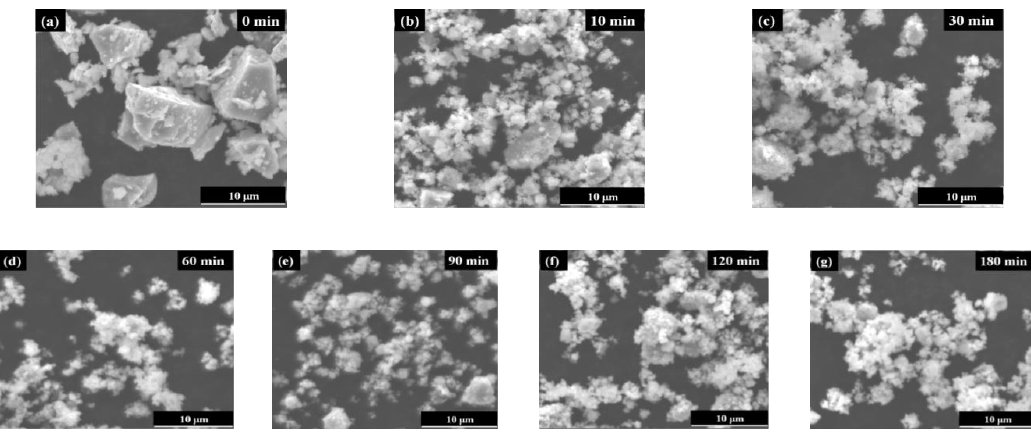
Figure 3. SEM micrographs of chalcopyrite ground for 0 min (unactivated) ( a ), 10 min ( b ), 30 min ( c ), 60 min ( d ), 90 min ( e ), 120 min ( f ), and 180 min ( g ).